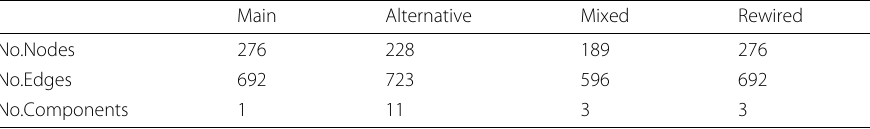
Table 1 Basic Network Descriptors